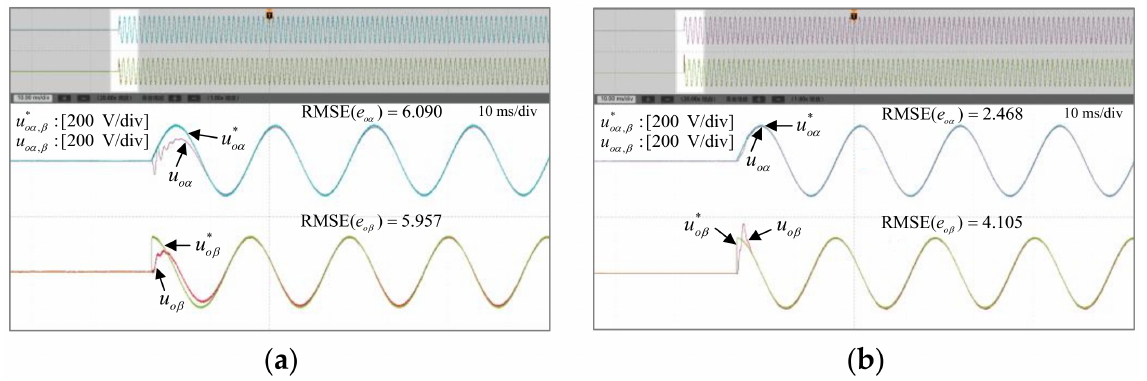
Figure 13. Experimental waveforms of voltage commands ( u * o α , u * o β ) and output voltages ( u o α , u o β ): ( a ) quasi-PRC; ( b ) proposed